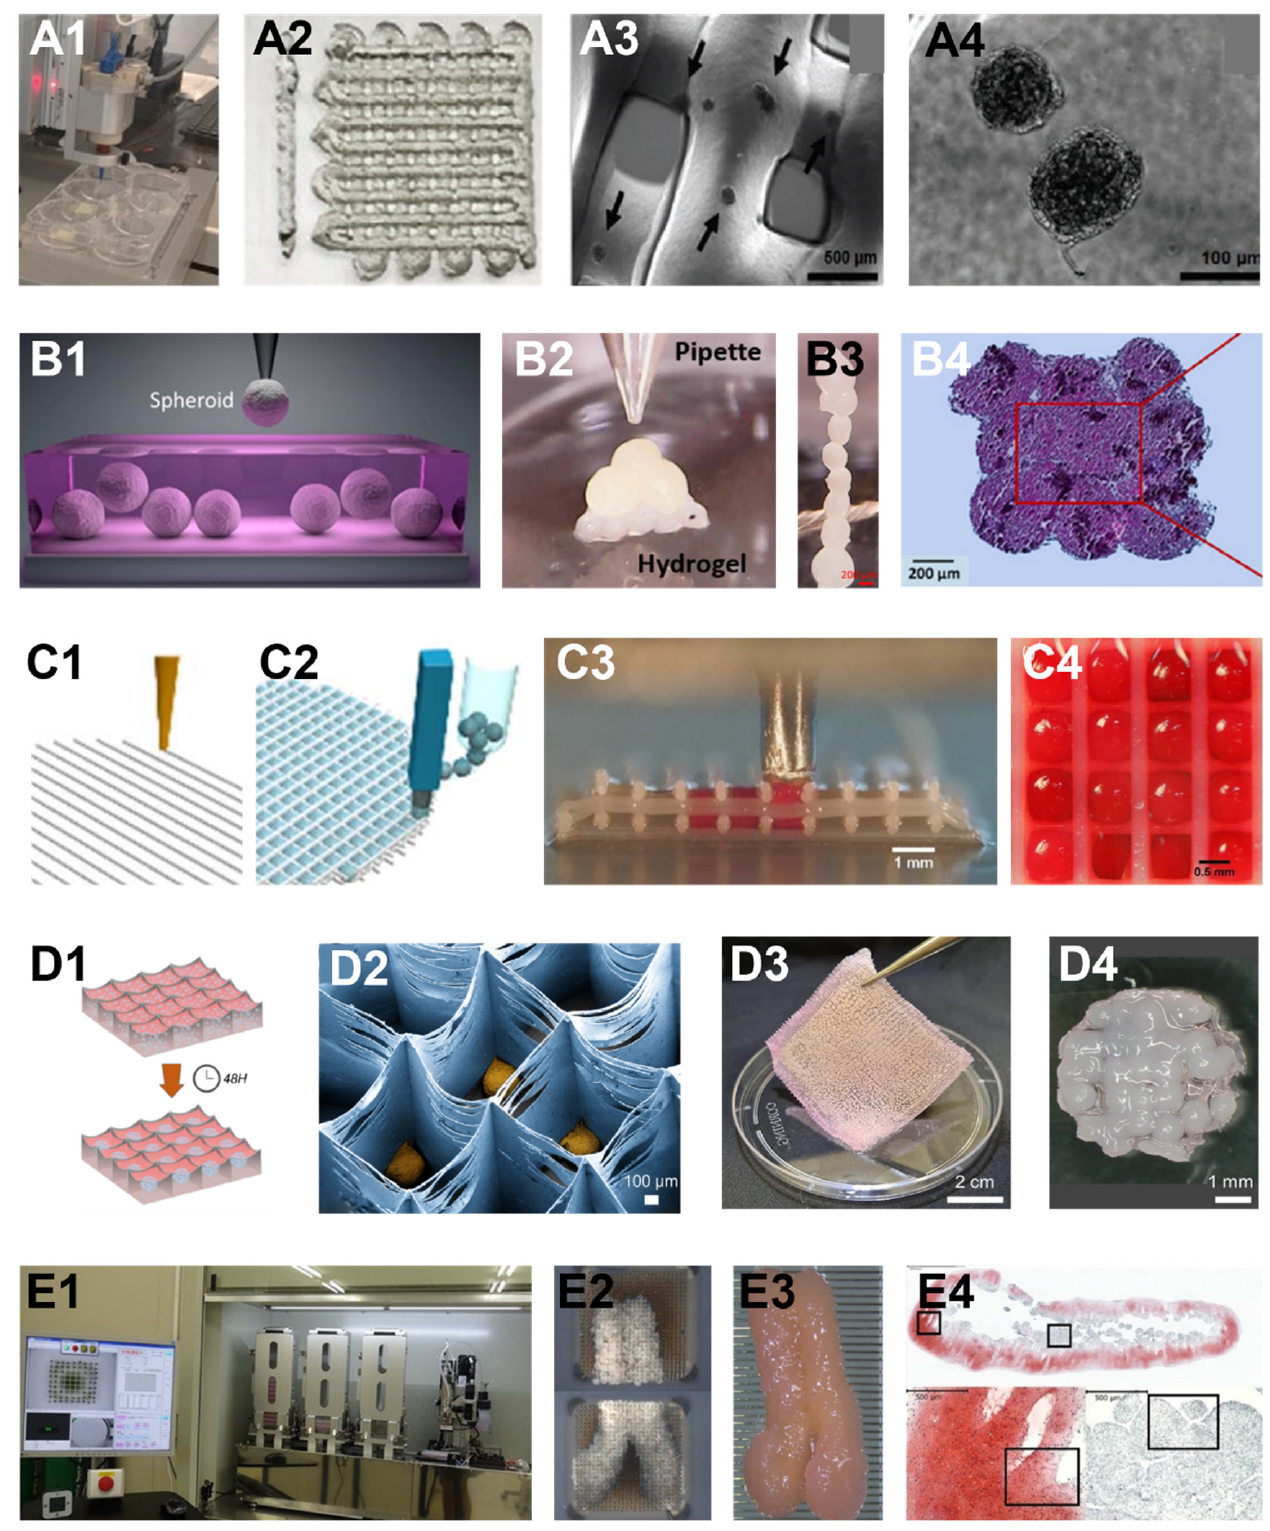
Figure 3. Examples of bioassembly methods using bioprinting. ( A 1– A 4) Extrusion-bioprinting-based bioassembly. Cellular spheroids were mixed with a hydrogel as bioink and loaded into an extrusion bioprinter ( A 1) to deposit bioink in the format of filaments to a substrate ( A 2– A 4, A 3, and A 4 are zoom-in views). ( B 1– B 4) Aspiration-assistant bioprinting for bioassembly. An aspiration tip was used to pick up individual spheroids ( B 1) and transfer the spheroids onto a hydrogel surface or into a hydrogel bath. The spheroids were eventually positioned in a predefined pattern ( B 2, B 3) and fused into a macro-tissue (histology, B4). ( C 1– C 4) Hybrid bioprinting uses two independent nozzles to deposit polymer filaments ( C 1) and spherical building blocks ( C 2). The hydrogel microspheres were deposited into each grid of the polymer filaments ( C 3, C 4). ( D 1– D 4) A different hybrid bioprinting method assembled a single layer of spheroids and a polymer slab ( D 1) with shallow chambers into a hybrid graft. MSCs were deposited into the chambers using inkjet bioprinting ( D 1). Spheroids were formed within each chamber ( D 2) and attached to the whole polymer slab ( D 3). A hybrid graft composed of polymer and fused spheroids was eventually formed ( D 4). ( E 1– E 4) A needle-array-based bioassembly method deposits spheroids into individual needles in a ‘kebab’ way ( E 1: bioprinter, E 2: spheroids in two needle arrays). The spheroids were fused